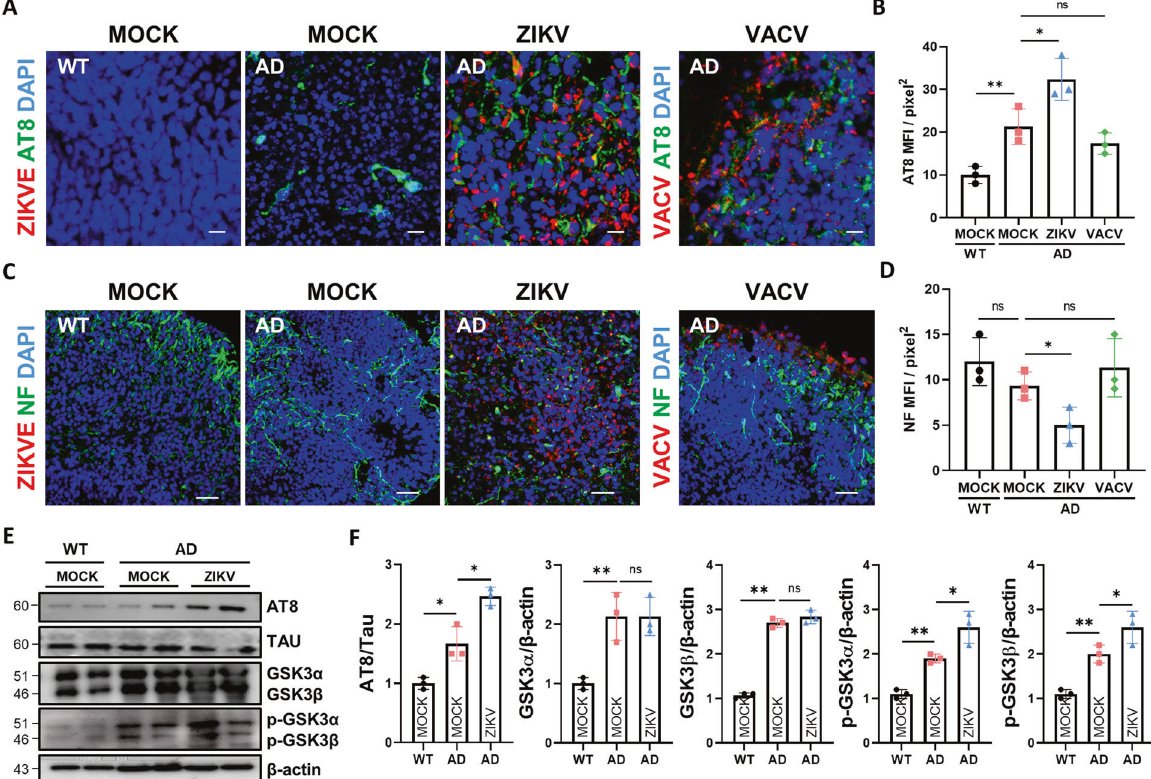
Fig. 4 ZIKV infection enhances p-TAU levels in AD organoids through GSK3 α / β . A Representative images of immunostained p-tau with AT8 (Ser202/Thr205), ZIKVE, and VACV antibodies. Scale bars, 10 µm. B Each graph bar represents the percentage of AT8-positive cells in the organoids. ( n = 3). C Representative images of immunostained NF and ZIKVE antibodies. Scale bars, 50 µm. D Each graph bar represents the percentage of NF-positive cells in the organoids ( n = 3). E Western blotting of p-Tau (AT8), Tau, p-GSK3 α / β , GSK α / β and β -actin in WT and AD organoids exposed to mock conditions and ZIKV. F Quanti fi cation of p-Tau (AT8), Tau, p-GSK3 α / β , GSK α and GSK3 β levels. p-Tau was normalized to total Tau. The others were normalized to β -actin ( n = 3). n.s.: not signi fi cant, * P < 0.05, and ** P < 0.01. The data are presented as the mean ±